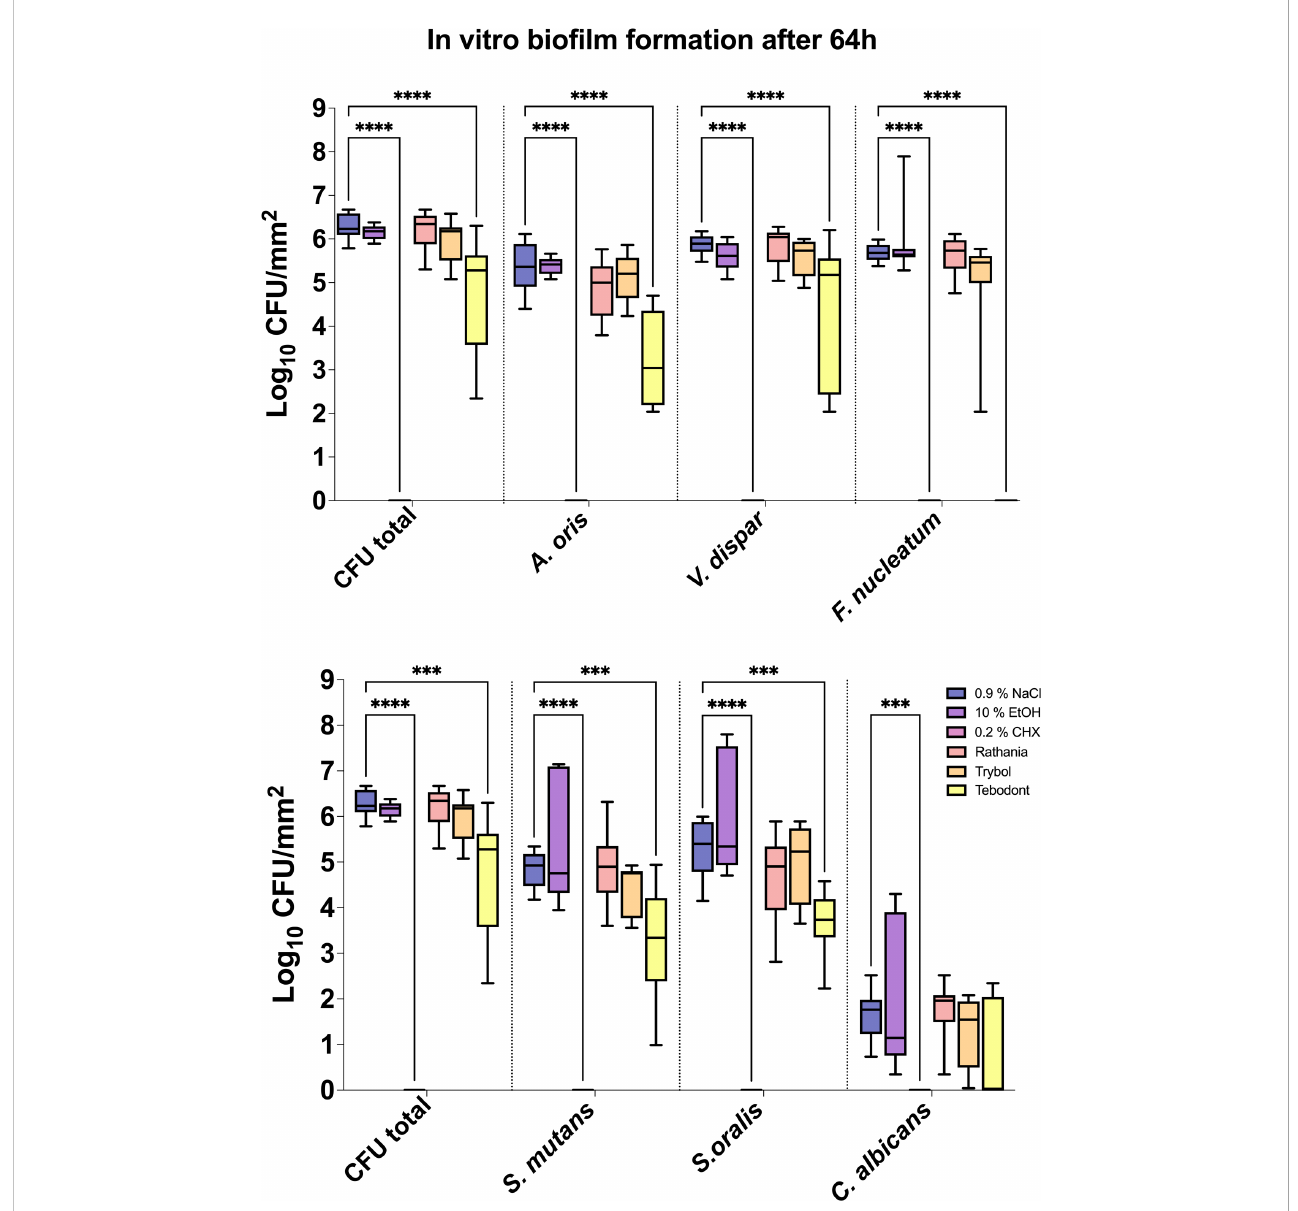
FIGURE 2 Box plots illustrating the colony-forming units (CFUs) of six-species oral bio fi lms after simultaneous exposure to the natural mouthrinses Ratanhia, Trybol, Tebodont. 0.2% CHX (positive control), 0.9% NaCl and 10% EtOH (negative control) were also used. The CFU values were shown on a log 10 scale per mm 2 (log 10 / mm 2 ). The line dividing the box shows the median. The p-values of the signi fi cantly different data are plotted: ***= P-value <0.001, **** = P-value <